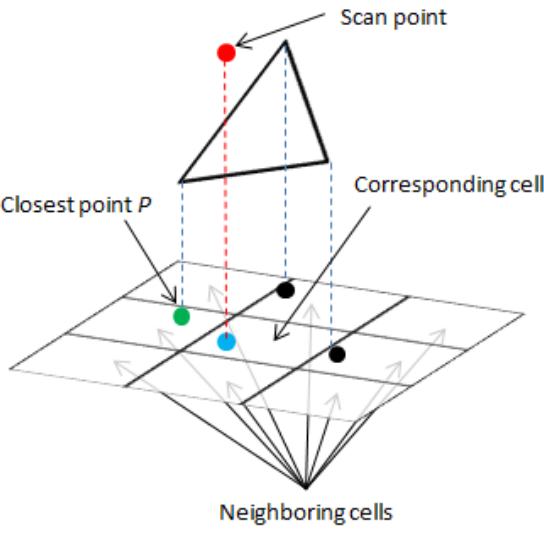
Figure 2. Example of a neighbor search on a grid when there is no triangle with a vertex in the queried cell, meaning that three 8-connected neighbors must be